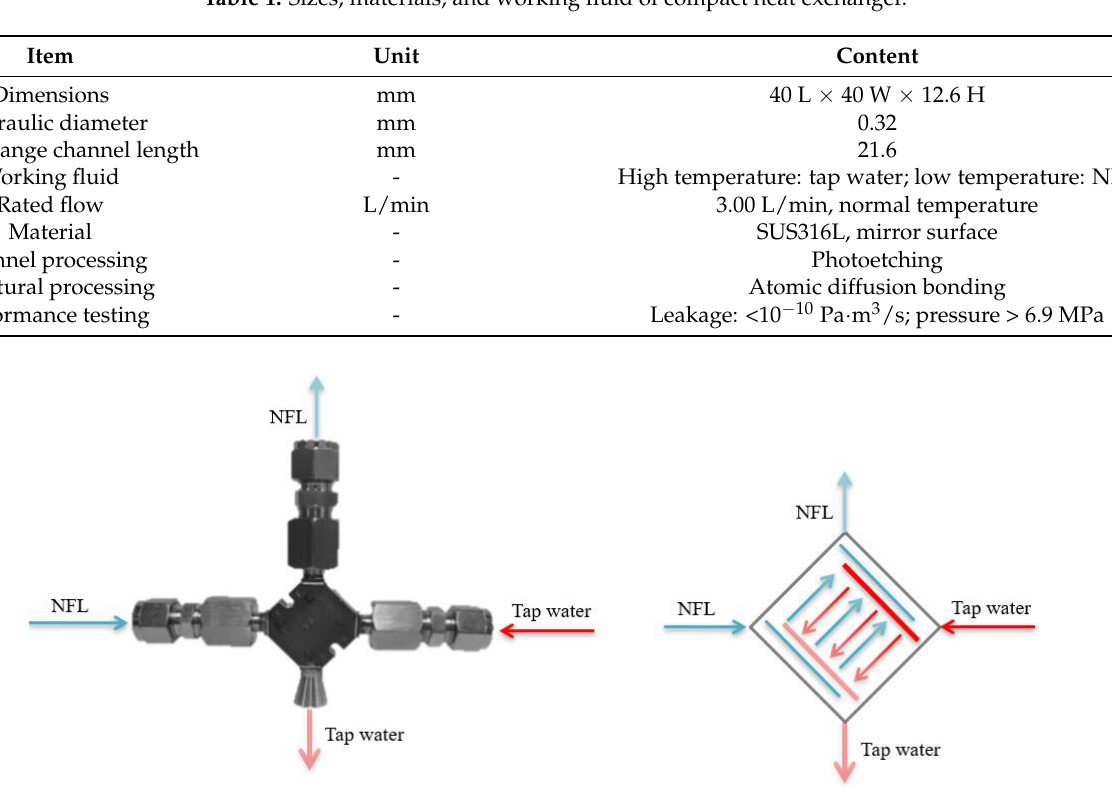
Figure 1. The compact heat exchanger and schematic of convection heat transfer.